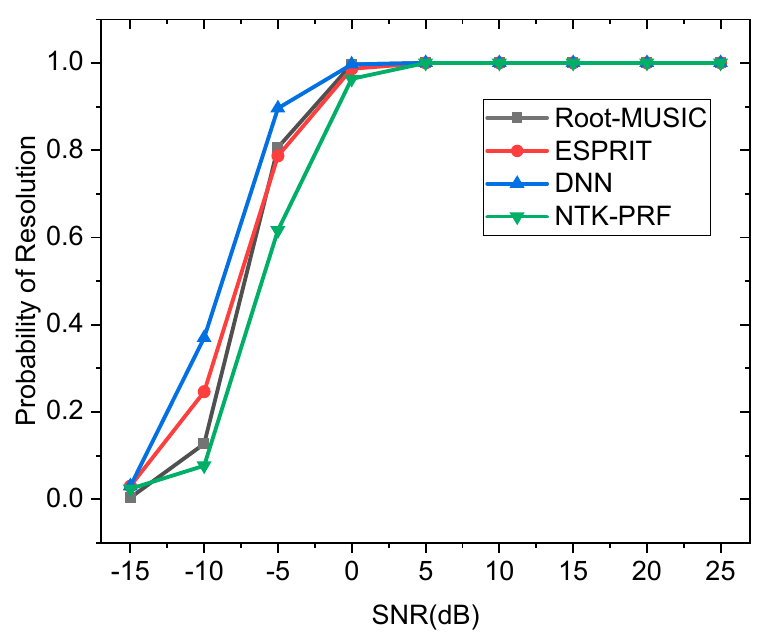
Figure 4. Probability of resolution with different methods versus SNR. Training data is at every 0.9° , and two DoAs are 70.09° and 85.05° respectively.